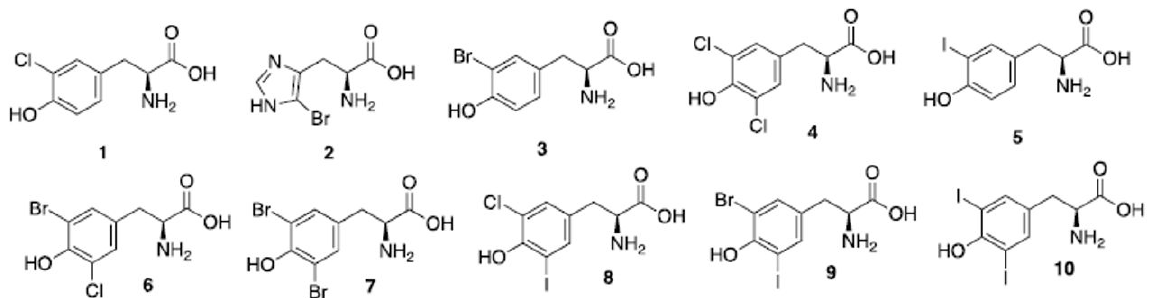
Figure 4. Natural halogenated tyrosines and histidine. In a recent study, tyrosines have been shown to be the preferential site of halogenation of peptides, variously leading to formation of compounds ( 1 ) and ( 3 – 10 ).